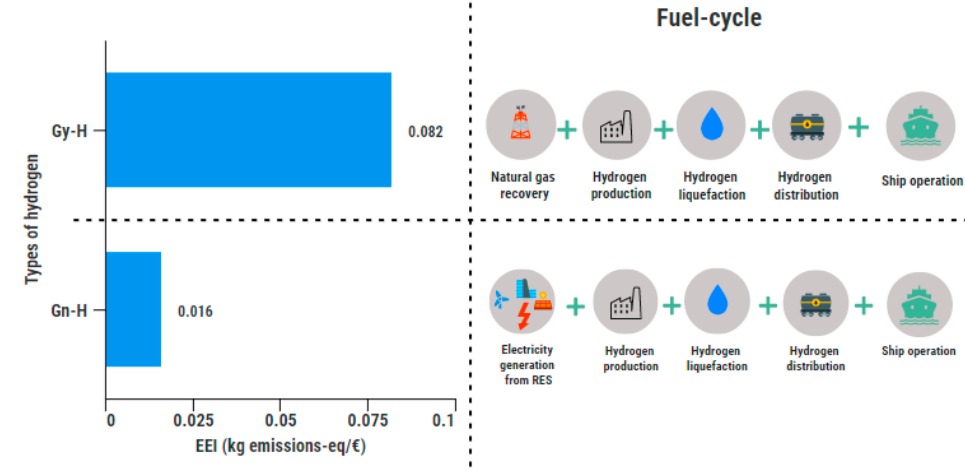
Figure 10. Impact of different hydrogen production processes on EEI.